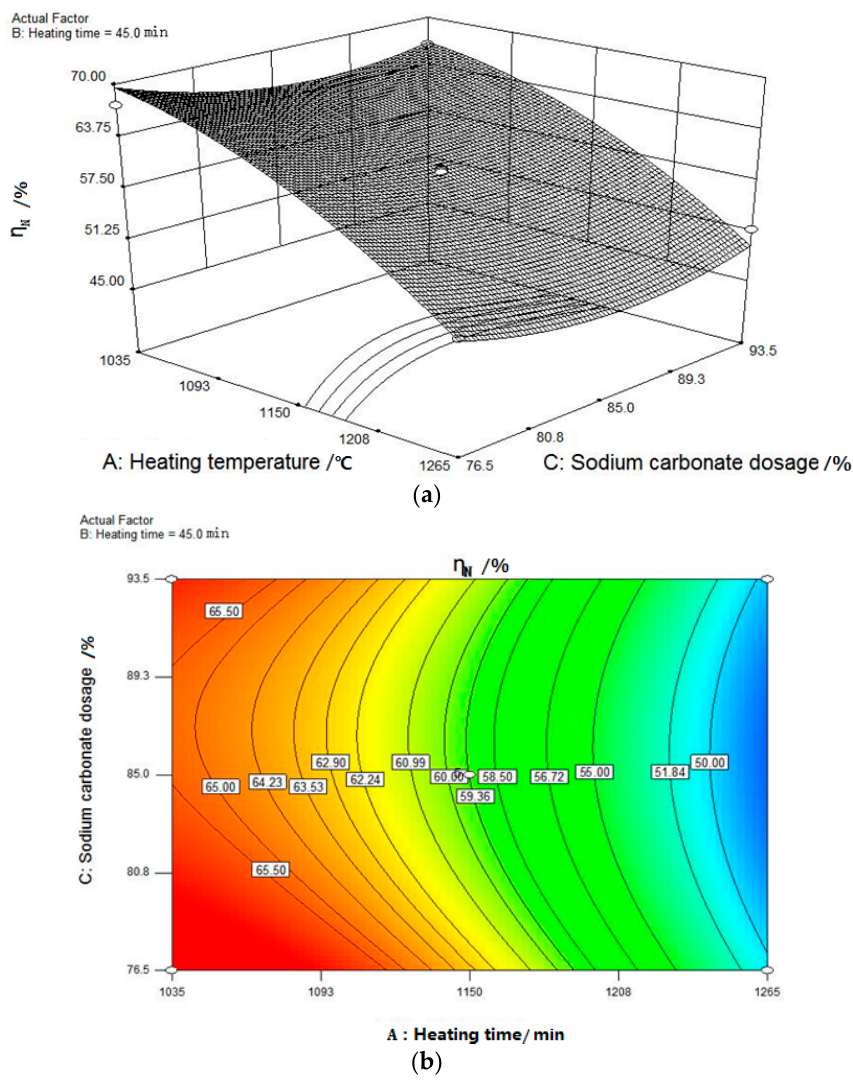
Figure 5. ( a ) Response surface of heating time–sodium carbonate dosage; ( b ) contour of heating time–sodium carbonate dosage plot.